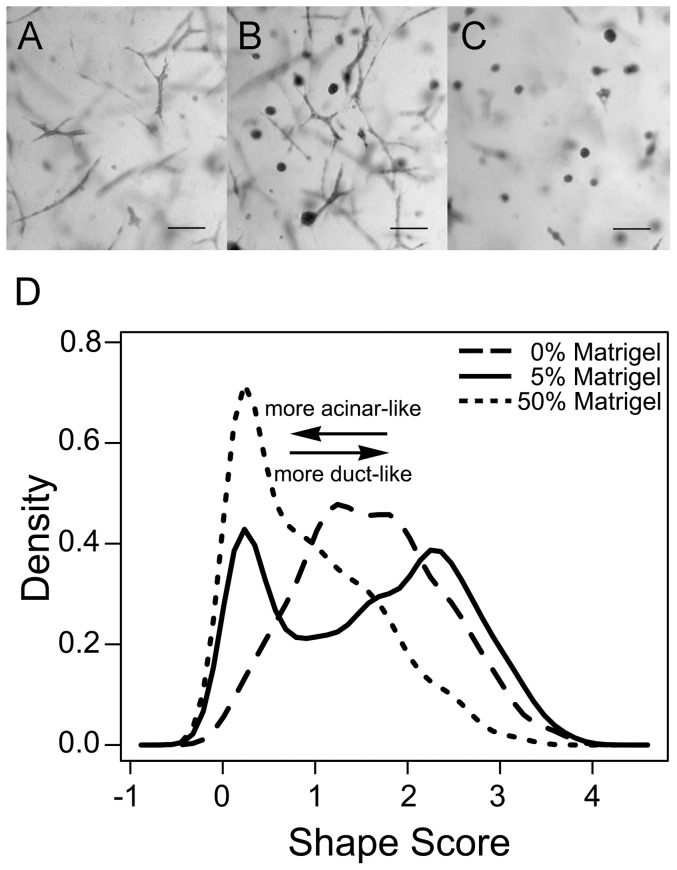
Matrix composition affects the proportion of ducts and acini.Brightfield images of (A) 0%, (B) 5% and (C) 50% Matrigel Carmine-stained whole-mounted gels. Scale bar, 100 μm. (D) Graph comparing the normalized abundance (density) of epithelial structures of different shape score (n = 3 gels).